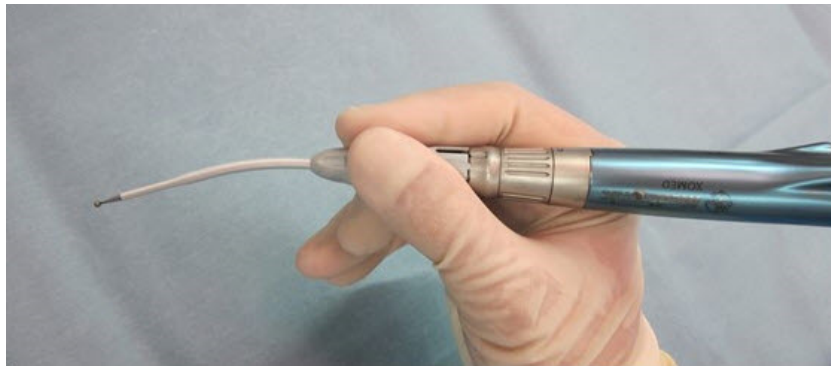
Figure 7. The high-speed drill with a curved burr at 80,000 rpm/1,333 Hz (Visao ® High-Speed Otologic Drill, Medtronic, Shinagawa, Tokyo, Japan) used for polishing bone during the transcanal atticoantrotomy.